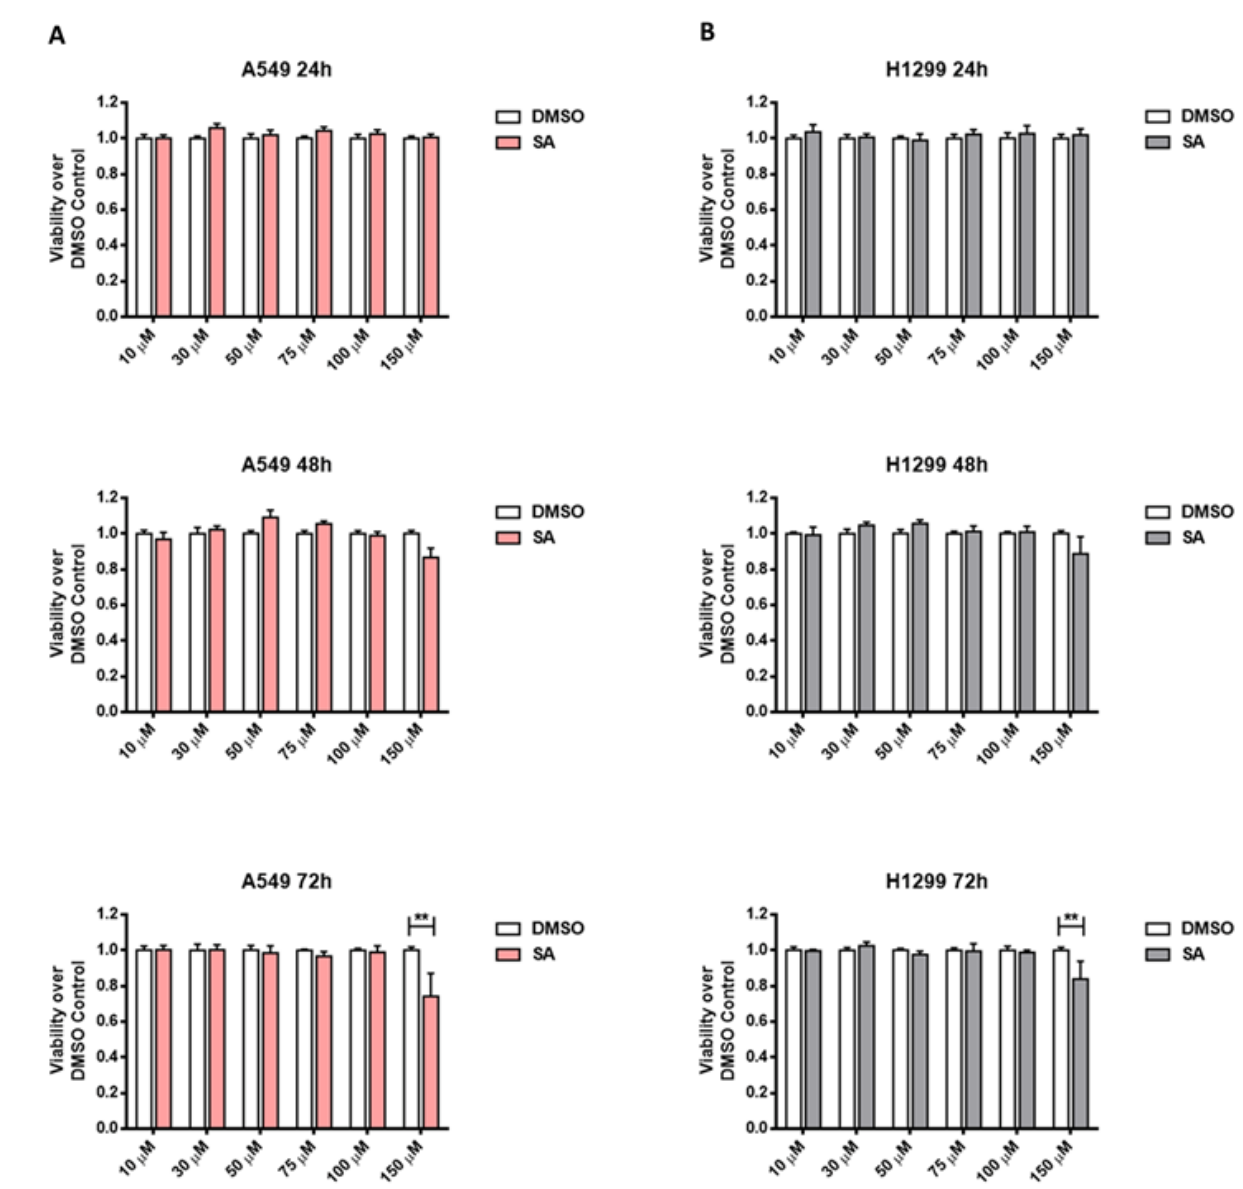
Figure 1. Sterculic acid induces cell death in a dose-time dependent manner in lung cancer cells cultured in 10% serum- supplemented medium. Cell viability after SA treatment (10–150 µM) was measured by MTS method. ( A ) Cell viability over DMSO control of A549 cells. White bars correspond to cells treated with vehicle (DMSO) while pink bars correspond to cells treated with SA (10–150 µM). ( B ). Cell viability over DMSO control of H1299 cells. White bars correspond to cells treated vehicle (DMSO) while grey bars correspond to cells treated with SA (10–150 µM). Data represented mean ± SEM of 48-well plates of at least three different experiments. ** p < 0.01.